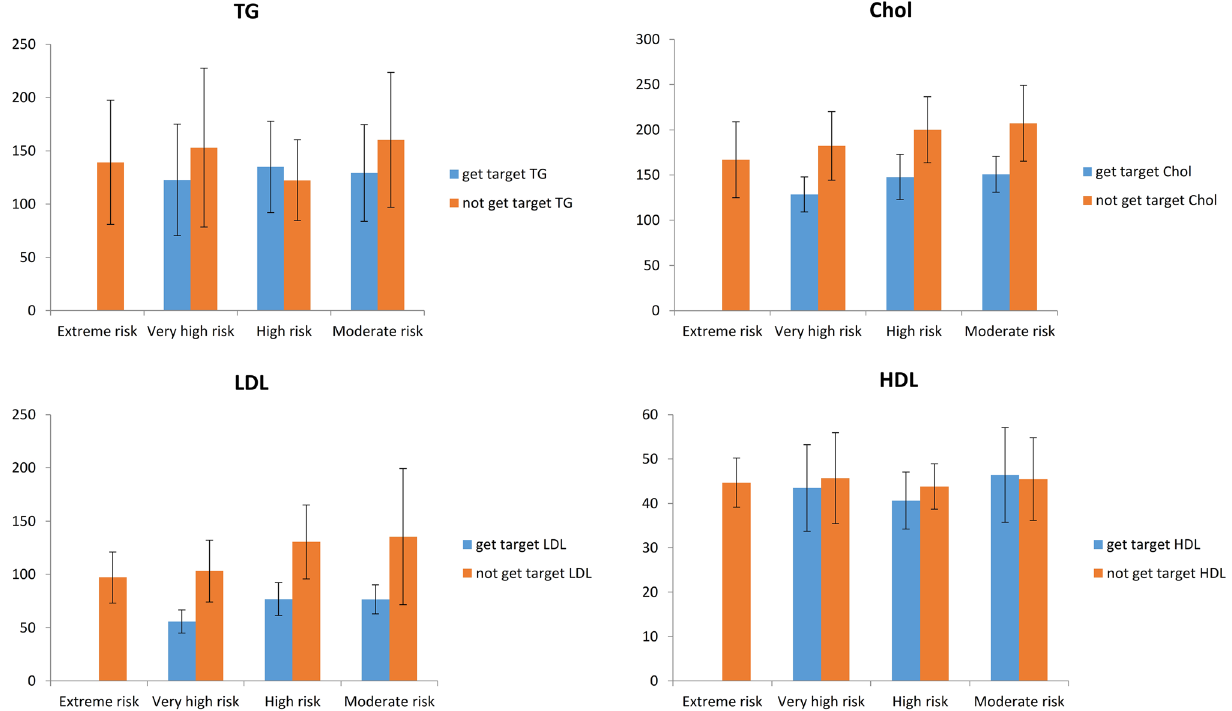
Figure 2. Comparison of lipid profile level between patients who get LDL goal and not achieved in different ASCVD risk level category groups.